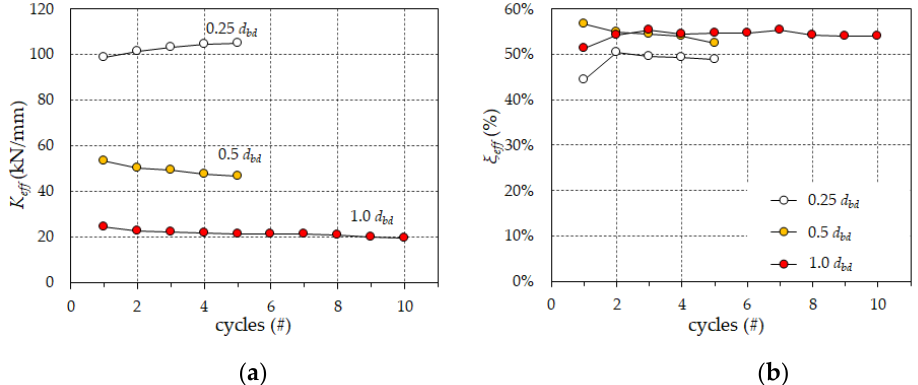
Figure 8. Variation of the properties of the PS-LED prototype in cyclic tests at different amplitudes: ( a ) the effective stiffness K eff ; and ( b ) the equivalent damping ratio ξ eff .